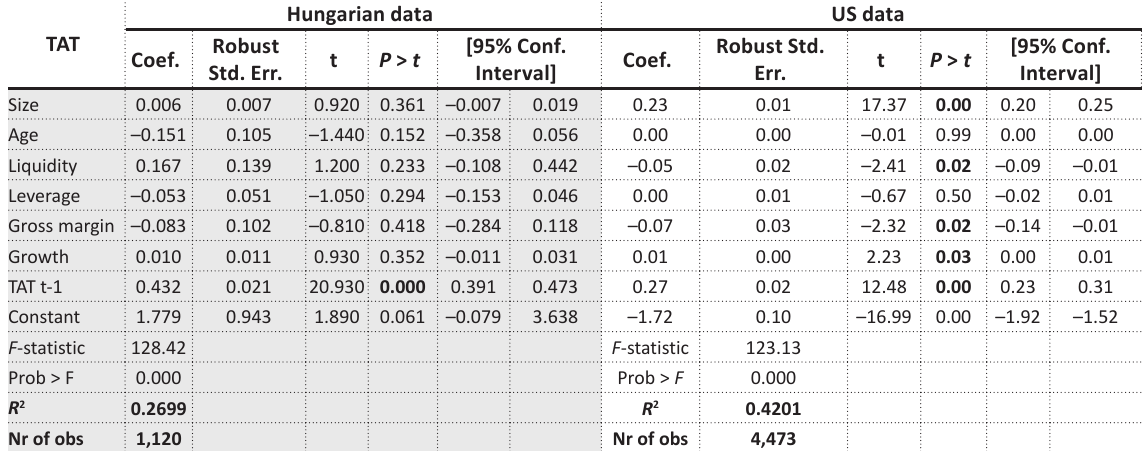
Table 6. Results of the fixed effect panel regression, 1st model, dependent variable: TAT Hungarian data TAT Age